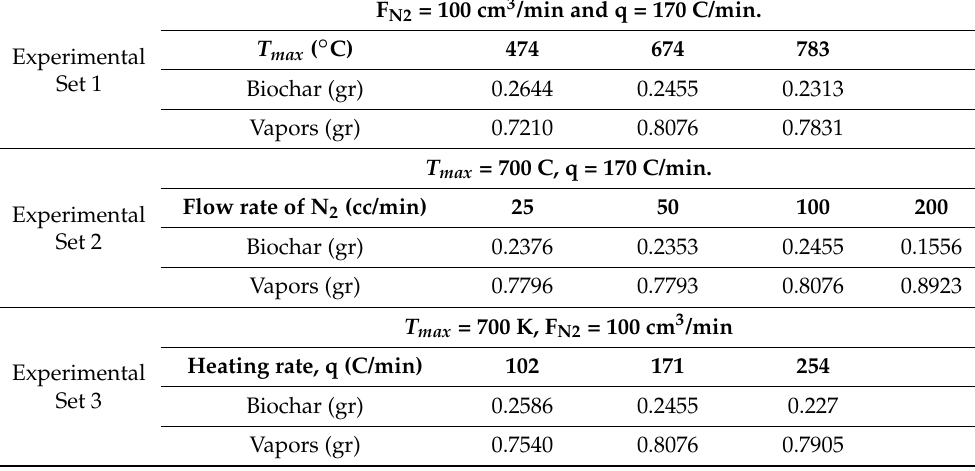
Table 3. Effect of pyrolysis conditions on product